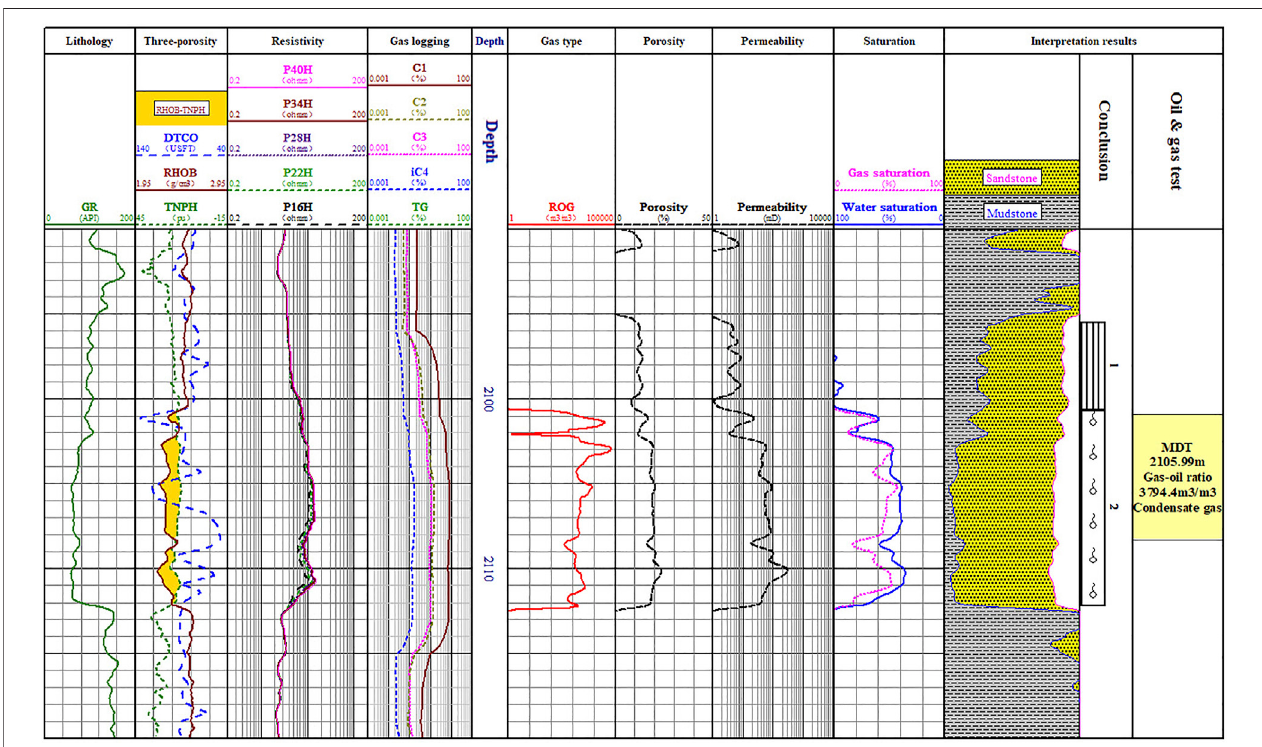
FIGURE 7 | Diagram of the logging interpretation results of well O-A2 (2090 – 2120